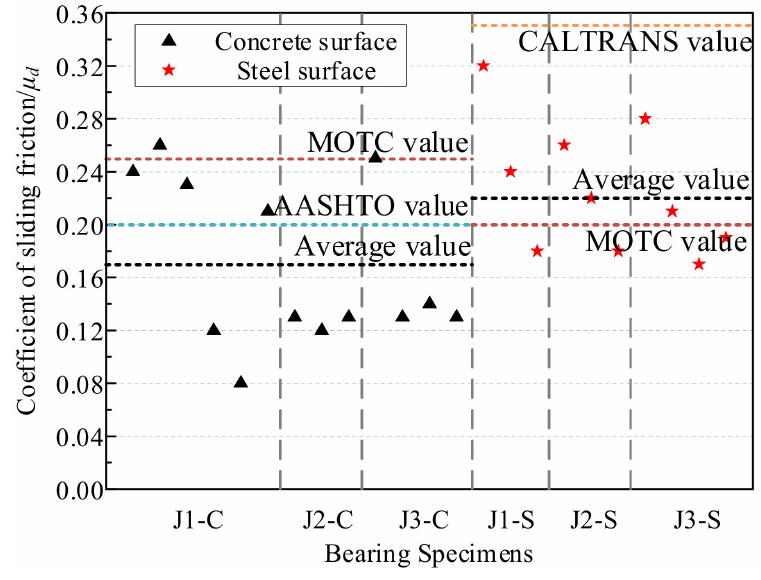
Figure 9. Distribution of the µ d of the